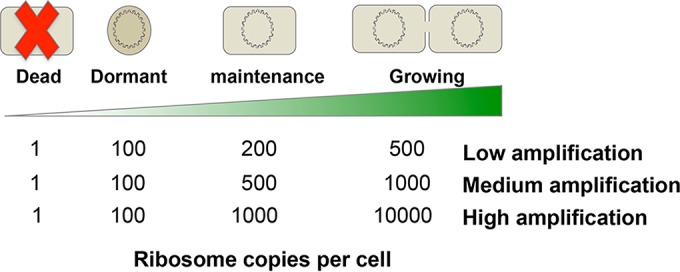
rRNA amplification and random assignment of cells to metabolic states. Three different rRNA amplification models were used to represent variation in the abundance of ribosomes in cells in four metabolic states. The number of ribosomes per cell in each of the activity metabolic states with the different rRNA amplification models is indicated. Data for the rRNA amplification models were based on data from Table S1. For simulations, each population in a community represented a mixture of cells in different metabolic states. The number of cells in a given population was determined from a community structure model. The cells in a population were randomly assigned to four metabolic states, and the net activity status of each population was calculated.